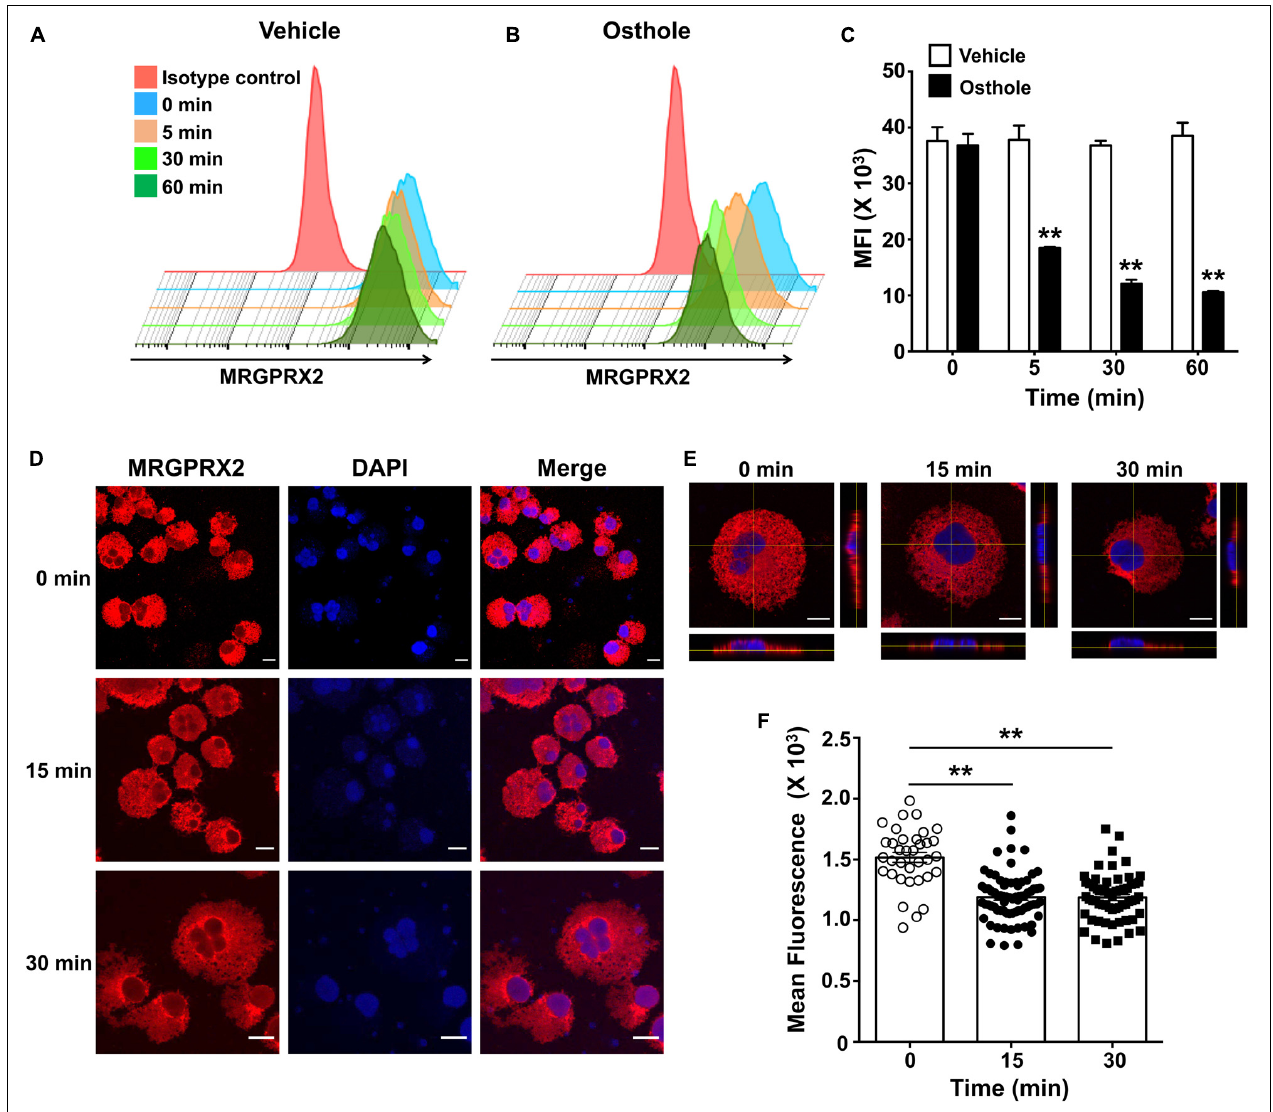
FIGURE 8 | Osthole decreases the expression of MRGPRX2 in LAD2 mast cells. LAD2 cells were exposed to (A) vehicle or (B) osthole (72 µ M) for the indicated time points, washed, stained with PE conjugated MRGPRX2 antibody and analyzed by flow cytometry. Representative histograms of MRGPRX2 surface expression at different time points after vehicle or osthole exposure are shown. (C) Bar graph shows the mean fluorescence intensity (MFI) of MRGPRX2 receptor expression following vehicle or osthole treatment. Data are mean ± SE from three experiments. Statistical significance was determined by unpaired Student’s t -test comparing the vehicle vs. osthole treated groups * p < 0.05 and ** p < 0.01. (D) Immunofluorescence staining of MRGPRX2 was performed in LAD2 cells treated with osthole (72 µ M) for different time intervals. Representative images of MRGPRX2 expression (red) and nucleus (DAPI) are shown. Scale bar = 10 µ m. (E) Z-stack confocal microscopy images with cross-sectional views taken at 100 x magnification show localization of MRGPRX2 (red) after osthole exposure. (F) Bar graph shows mean fluorescence intensities corresponding to MRGPRX2 expression in LAD2 cells obtained from the confocal experiments. Data represent mean ± SE from three experiments with 30–70 cells analyzed in each group. Statistical analysis was done using unpaired t -test ** p <